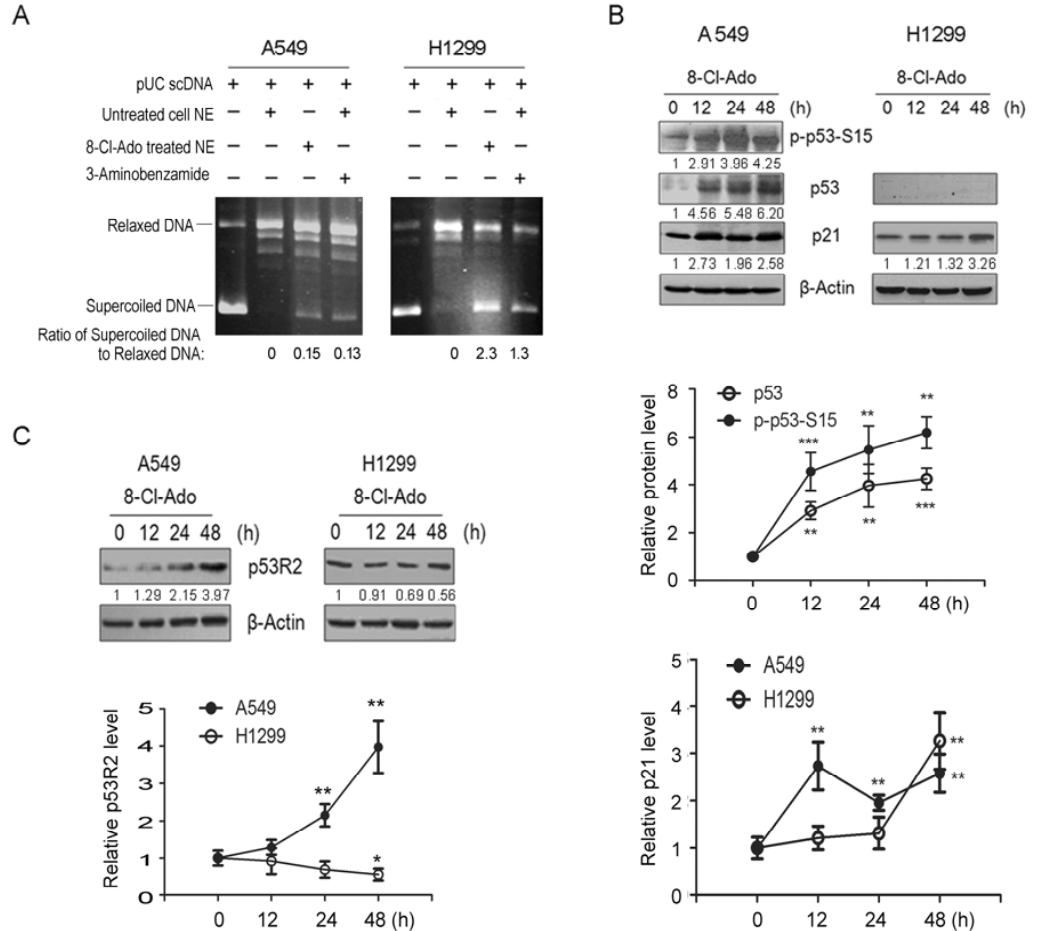
Figure 2. Effects of 8-Cl-Ado on DNA relaxation and on p53, p21 and p53R2 expression. ( A ) A549 and H1299 cells were exposed to 2 μ M 8-Cl-Ado for 48 h, and nuclear extracts (NE) were prepared. Relaxation activities in NE were tested by incubating with supercoiled pUC19 DNA in the reaction conditions as indicated on the top. After ethanol precipitated, extracted DNA samples were subjected to 1% agarose gel electrophoresis. The pUC19 DNA is used as markers for supercoiled and relaxed DNA; ( B , C ) Western blotting for p53, p21 and p53R2 expression. β -Actin as a loading control. The numbers below the blots and histograms in lower panels show the relative levels of p53, p21 and p53R2 in Western blotting. The ratio of target protein/Actin from control cells was designated as “1” . * p < 0.05; ** p < 0.01; *** p < 0.001.